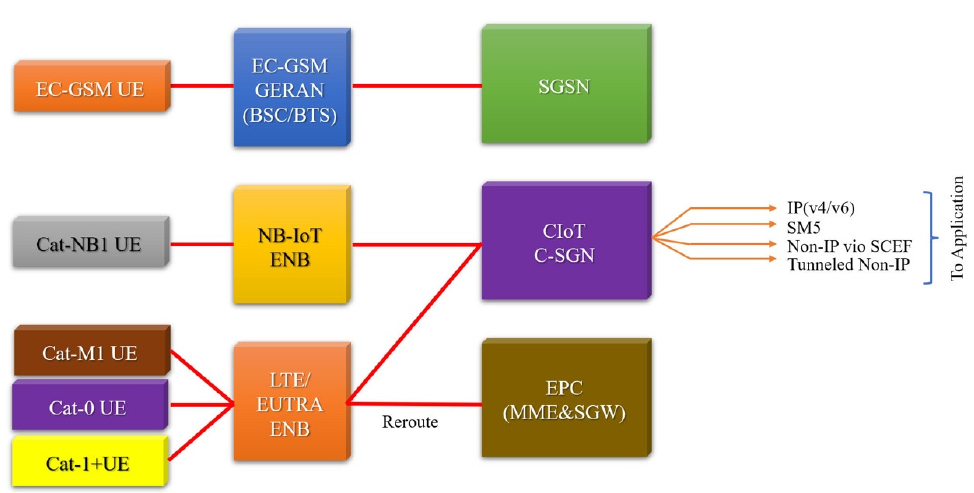
Figure 16. IoT Technology Classification of Licensed Spectra.